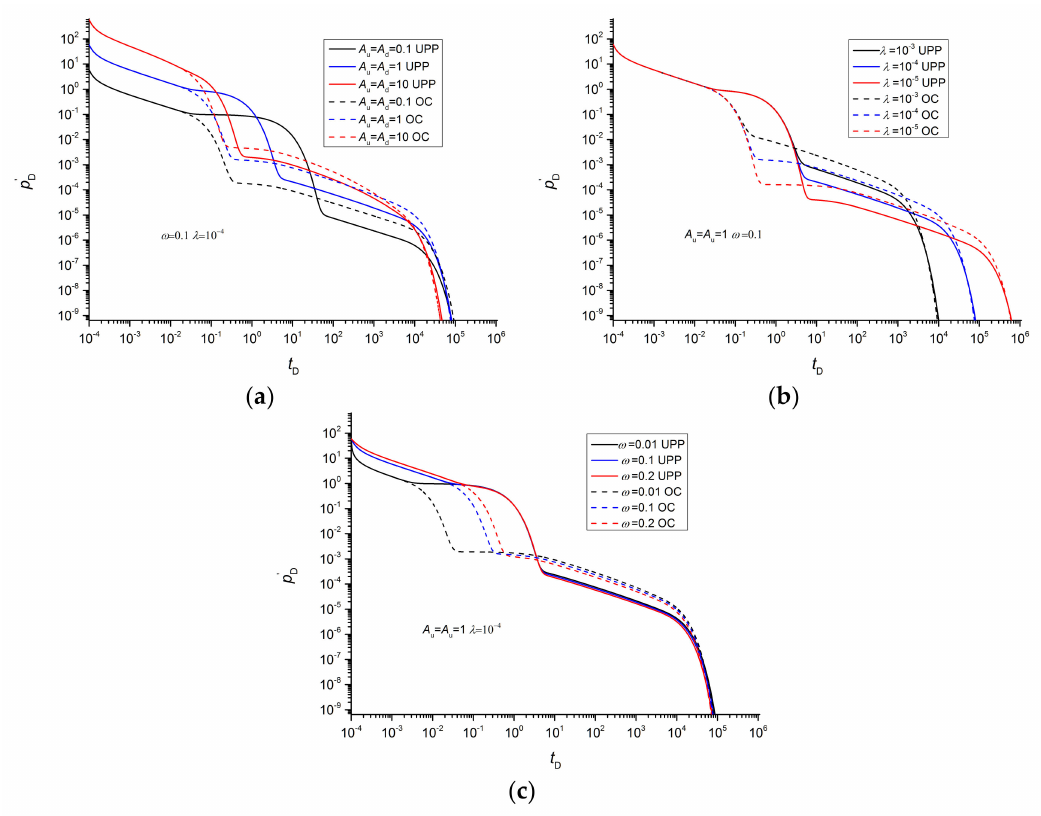
Figure 10. Comparison of pressure derivative curves between the UPP method and OC method: ( a ) A u and A d ; ( b ) interporosity flow coe ffi cient; ( c ) storativity ratio. Table 1. Fracture permeability error caused by using the homogeneous model for dual-porosity cores ( A u = A d =